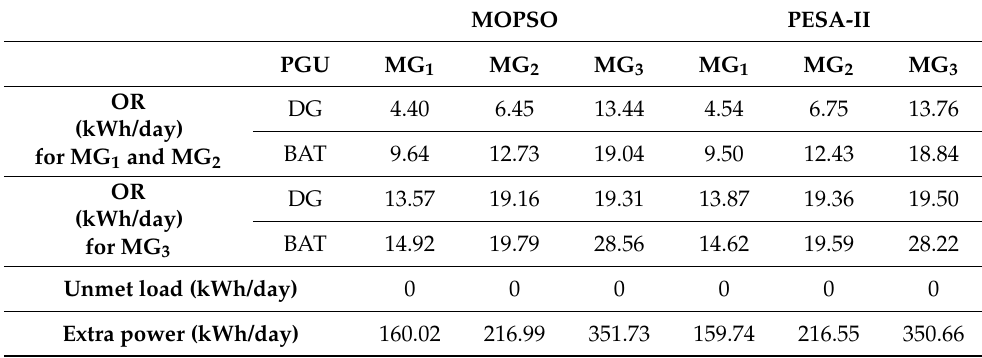
Table 6. Optimal operation of the